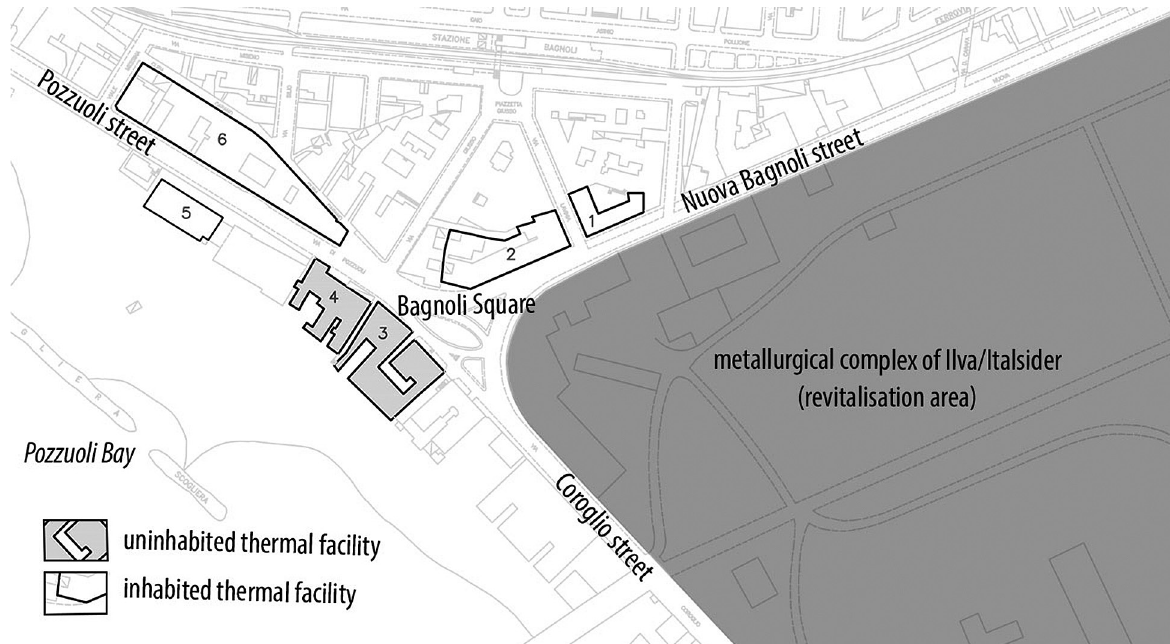
Fig. 1. Location map of selected non-functional thermal facilities in the Bagnoli district. Source: own elaboration based on the data from the private archive of G.